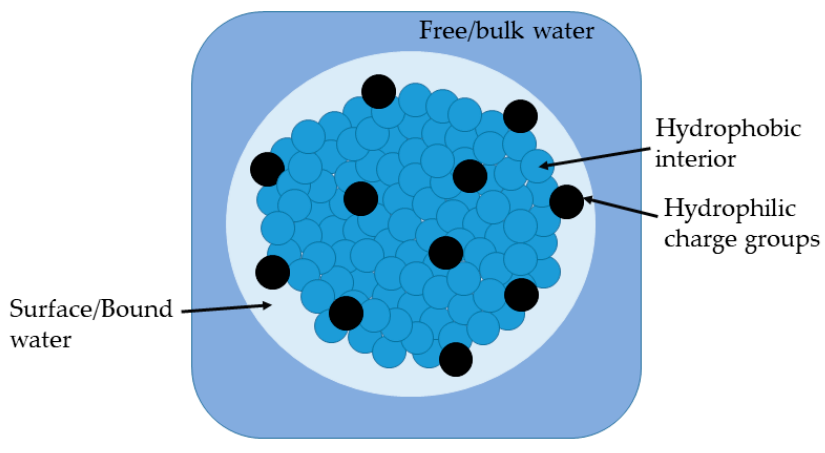
Figure 4. Structure of CUP particle suspended in water.